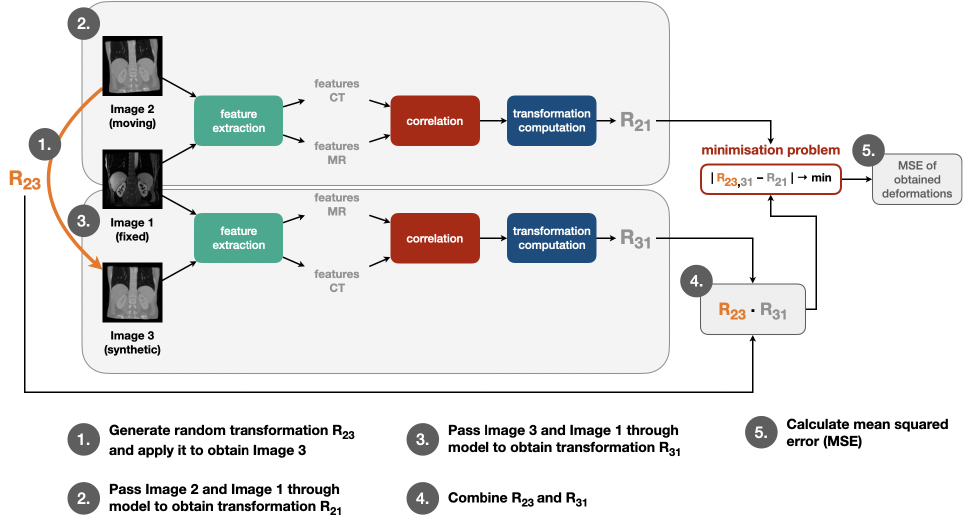
Figure 2. Pipeline to train our registration model: A random transformation matrix R 23 is generated and used to obtain the synthetic image. The pair of moving and fixed image as well as the pair of synthetic and fixed image are passed through feature extraction, correlation layer and transformation computation module (see following Sections 2.3 and 2.4) to obtain the transformation matrices R 21 and R 31 . Then, R 23 and R 31 are combined to obtain R 23,31 . As a final step, the mean squared error (MSE) of the deformations calculated with help of R 21 and R 23,31 is